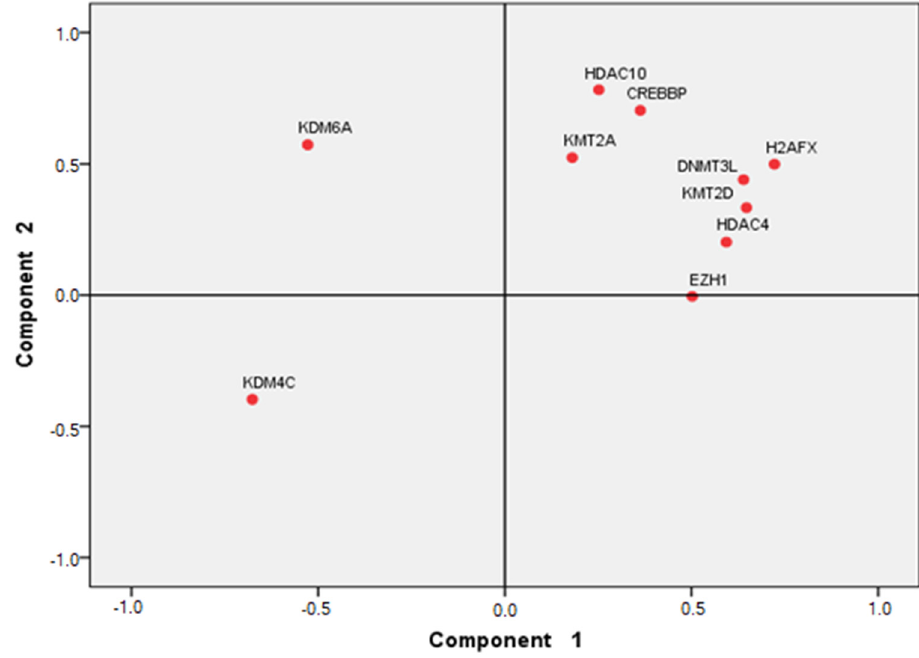
Figure 3. Principal component analysis of post-training samples with the overexpressed genes found in this study shown as red dots.